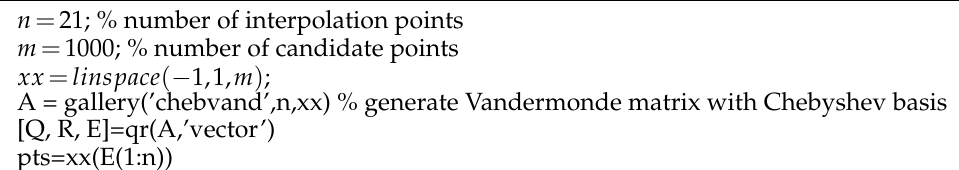
Algorithm 2 Example Column-Pivoting QR